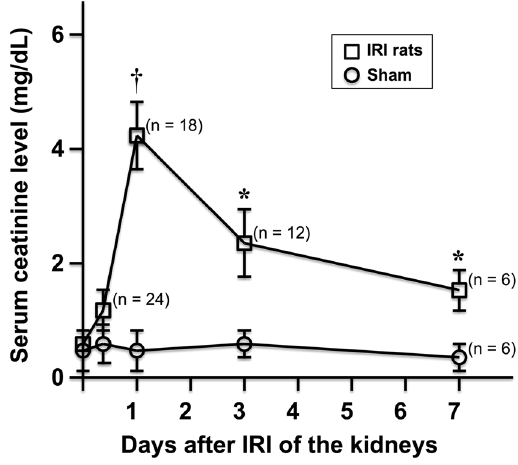
Figure 1. Changes of serum creatinine levels over time. After severe IRI of both kidneys, a trend of elevation of serum creatinine level was noted at 6 hours (P = 0.052) but afterward, significantly elevated serum creatinine levels were noted at all time points as compared with the sham control (n = 6), with peak level at day 1 († indicates P < 0.001, * indicates P <